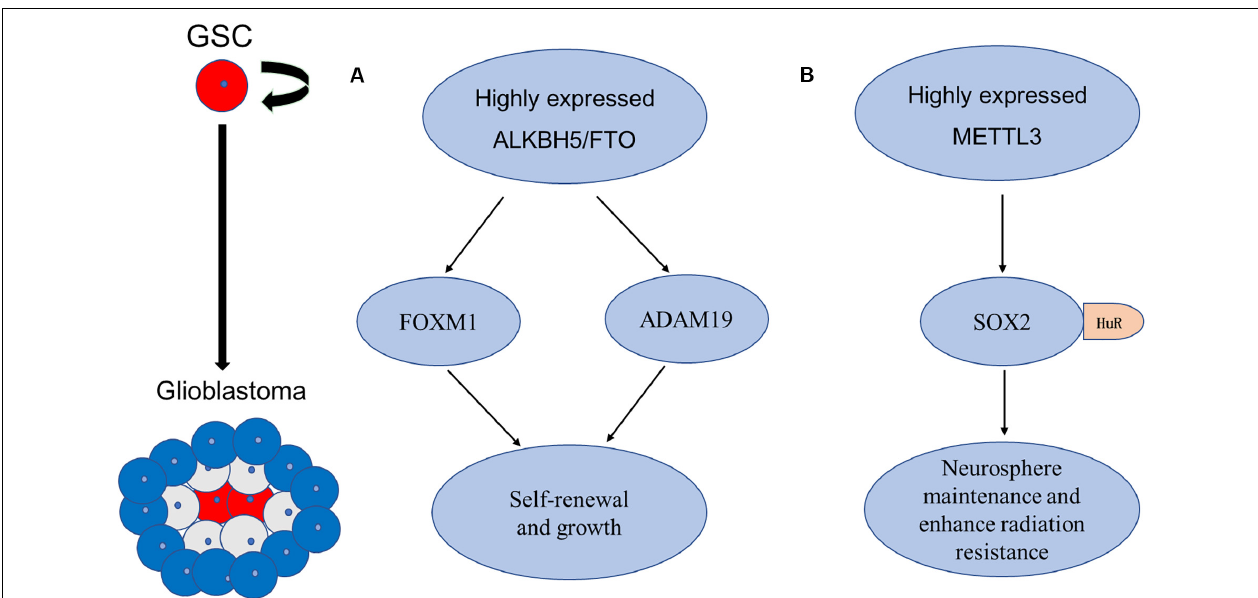
FIGURE 4 | Schematic elucidation of m6A in GSCs. (A) Cui et al. and Zhang et al. found that RNA m6A demethylase ALKBH5 and FTO are aberrantly expressed in GSCs, and they enhance self-renewal and tumorigenesis of GSCs through regulation of FOXM1 and ADAM19, respectively. (B) Visvanathan et al. found that METTL3 is upregulated in GSCs. METTL3-mediated methylation in SOX2 mRNA through recruitment of HuR to enhance its stability in GSCs, the increased level of the SOX2 enhanced radiation